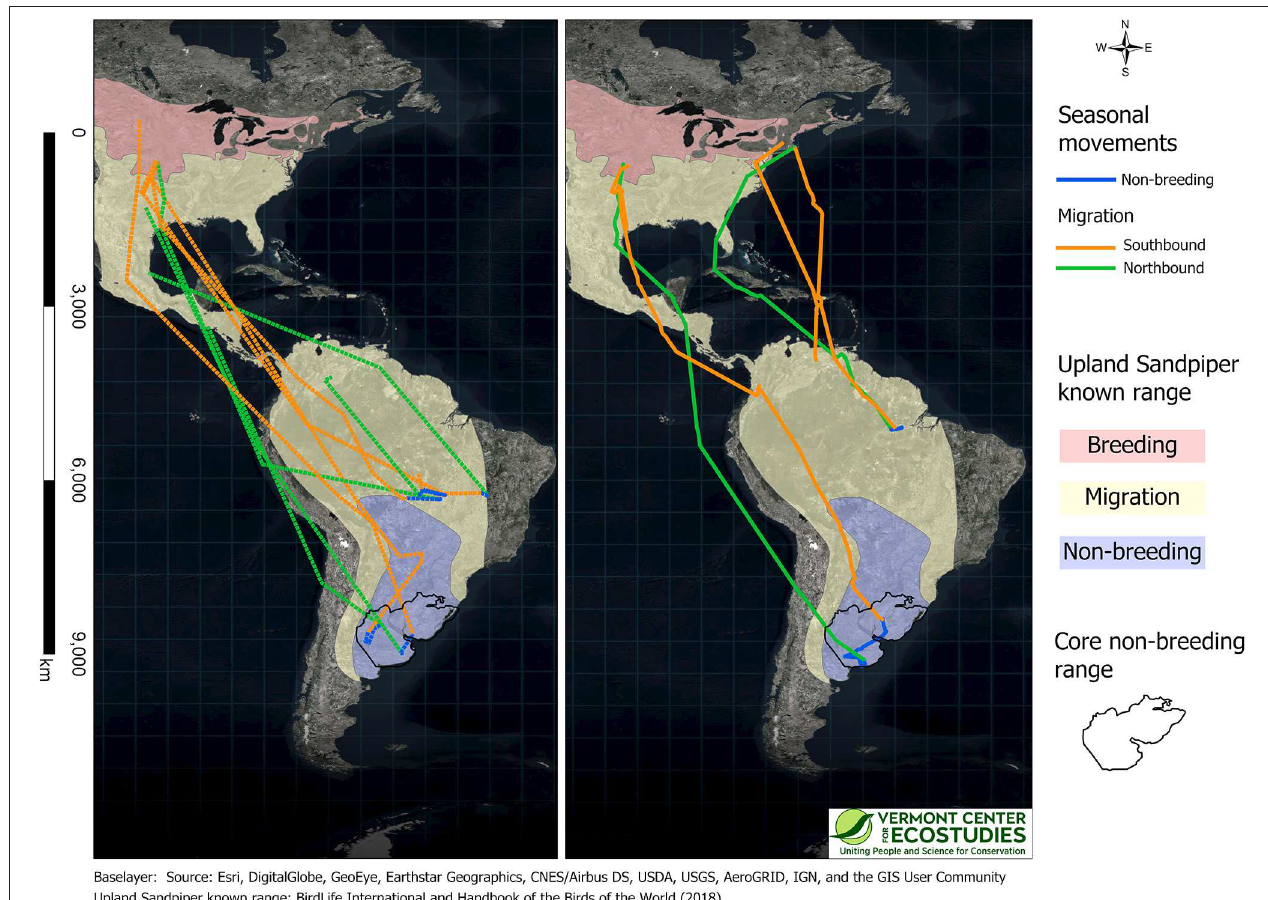
FIGURE 3 | Annual movement paths for nine Upland Sandpipers captured in Kansas or Massachusetts and tracked with GPS ( Left , dashed lines, n = 5 birds) or PTT tags ( Right , solid lines, n = 4 birds). We recorded complete tracks for six birds (4 GPS, 2 PTT), only northbound migration for one bird with a GPS tag (WO-GPS-62) and only southbound migration for two birds with PTT tags (KO-PTT-69 and WO-PTT-68). Movement paths were drawn by connecting consecutive locations with orthodromes, and include southbound migration (Aug-Nov, orange), winter movements (Dec-Feb, blue), and northbound migration (Mar-May, green). Colored semi-transparent polygons are the known breeding, migration, and non-breeding range of Upland Sandpiper (BirdLife International Handbook of the Birds of the World, 2018 ), and are reproduced with permission here. The core non-breeding range (black polygon, both panels) represents the area with the highest densities of Upland Sandpipers on the non-breeding grounds (reproduced with permission from Blanco and López-Lanús,